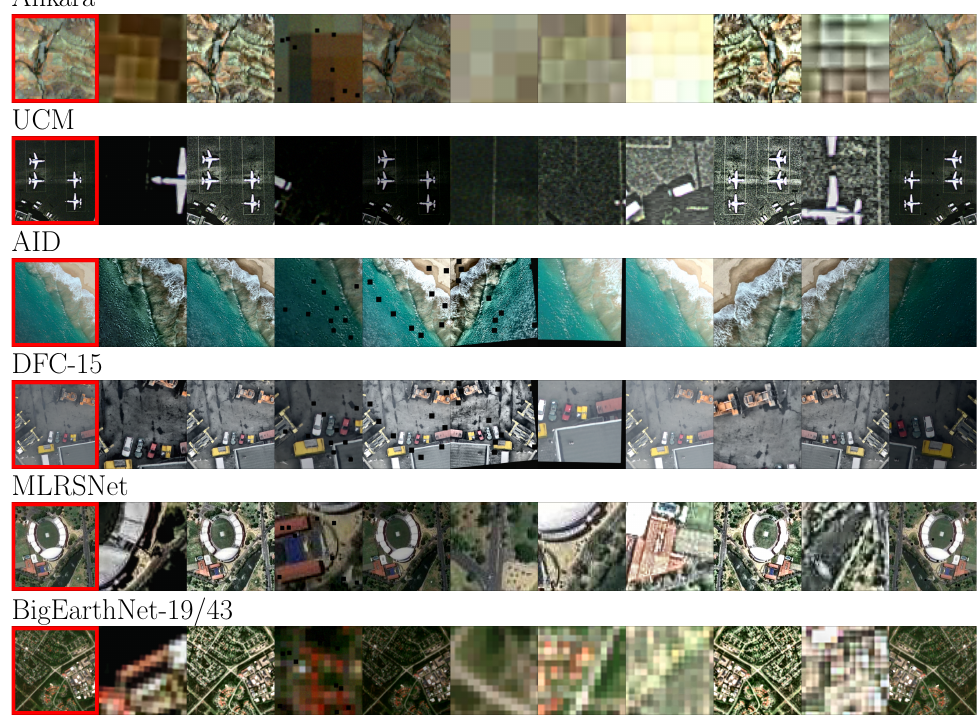
Figure 5. Augmentation examples. The left most image in each row marked with red is the original version, while the remaining images are the augmented versions. We can see the extent of variability added to the training datasets by the augmented